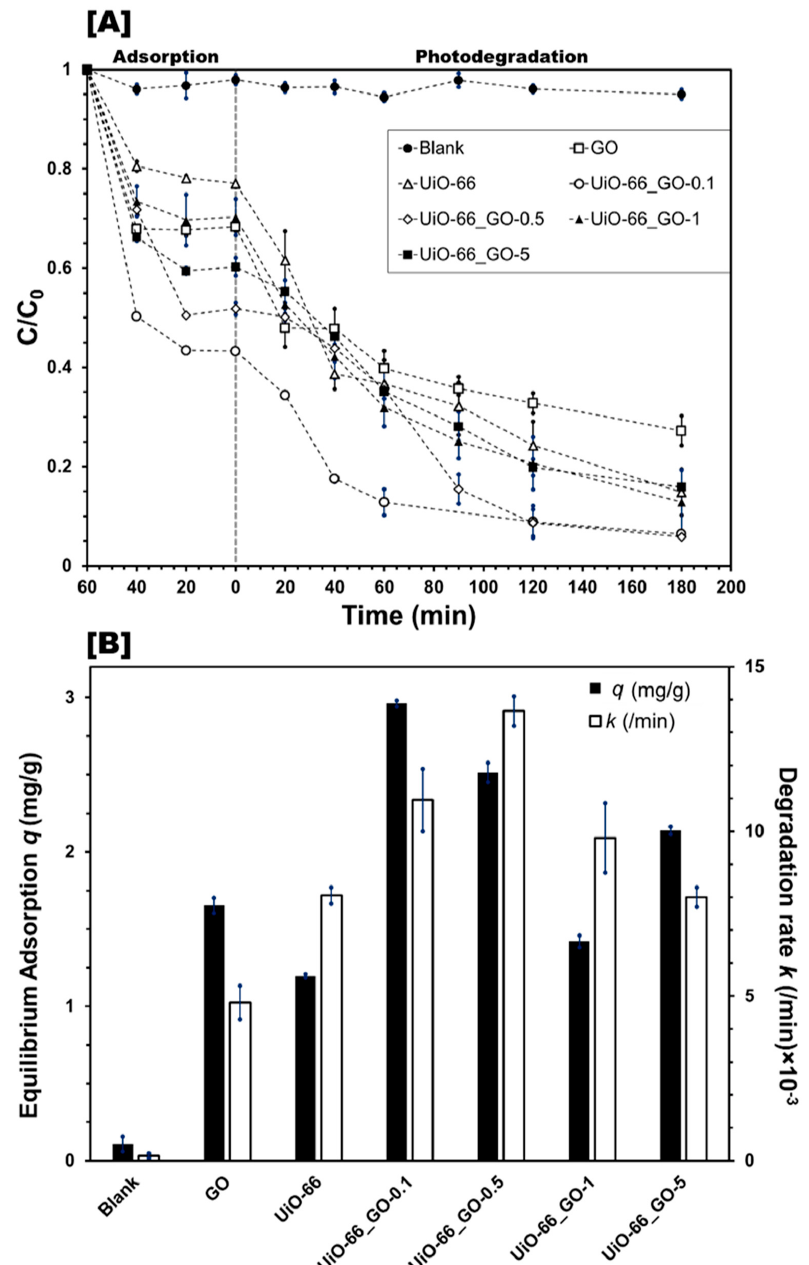
Figure 3. ( A ) Adsorption and photodegradation of CBZ, ( B ) adsorption capacity and photocatalytic rate k with no photocatalyst, GO, UiO66, 0.5 wt%, 1 wt%, and 5 wt% GO-loaded UiO-66 composites (experimental conditions: initial CBZ concentration = 5 mg/L; pH = 7±0.2; photocatalyst concentration = 1 g/L; solution volume V = 50 mL). Plots and error bars represent averages and standard deviations from triplicate experiments.